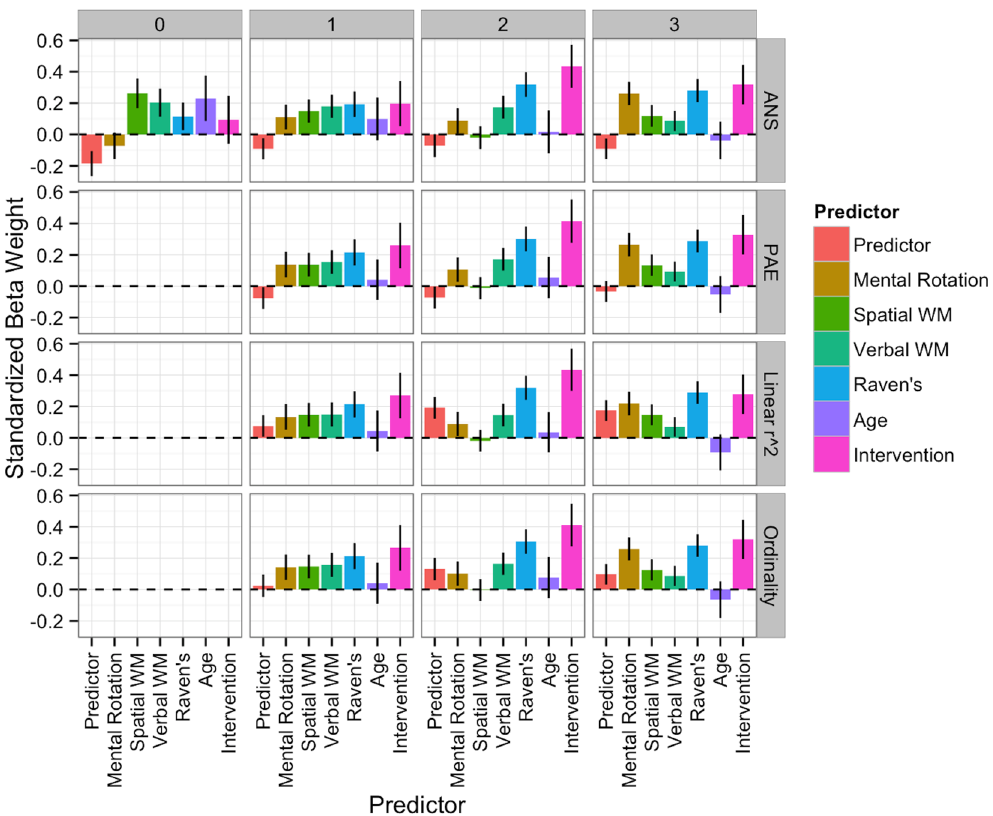
Figure 3. Standardized Beta weights (bars are standard error) when predicting our math PC1 from each of our predictors (ANS, PAE, Linear r 2 , and Ordinality), controlling for other non-numerical